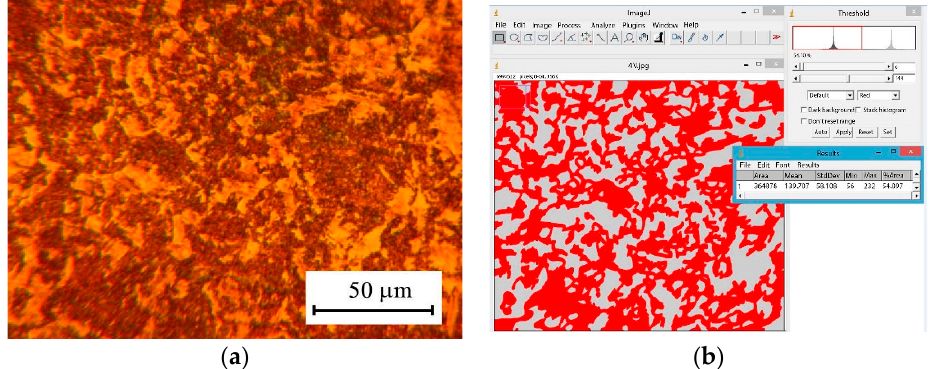
Figure 1. The microstructure of the 38KhN3MFA steel sample (initial state condition) ( a ) and the appearance of the ImageJ program dial window ( b ) (the area of the pearlite structural component is shown in red).